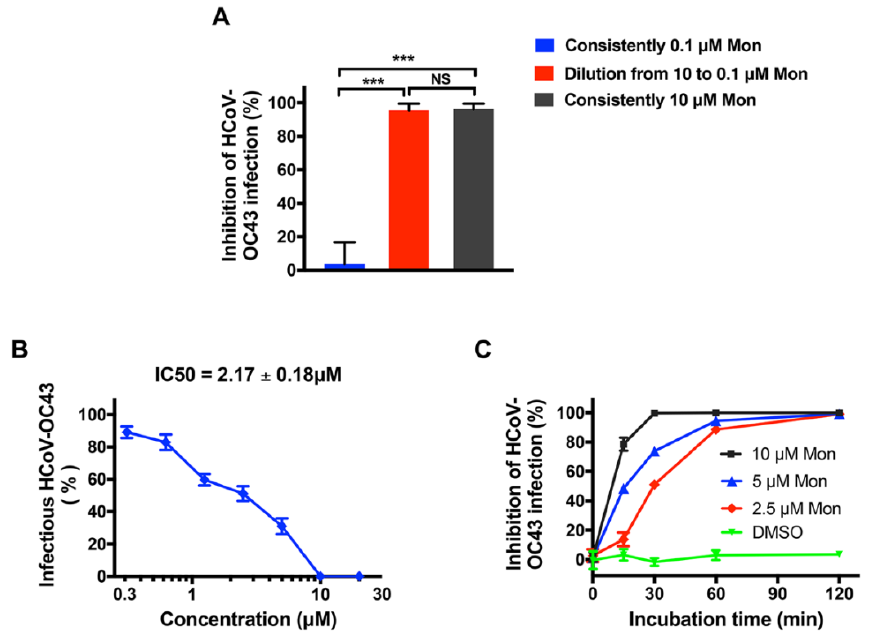
Figure 5. Montelukast (Mon) directly inactivated HCoV-OC43 particles in an irreversible and time-dependent manner. ( A ) Antiviral activity of montelukast against HCoV-OC43 was irreversible. The viruses were incubated with montelukast (10 µM) for 1 h, and then the mixture was diluted by 100-fold, resulting in decrease of the concentration of montelukast to 0.1 µM before per- forming plaque assay. ( B ) HCoV-OC43 virions were treated with serially diluted montelukast for 2 h at 33 °C. Then, viruses were precipitated and separated from montelukast by PEG-8000 and the plaque assay was performed to detect HCoV-OC43 infectivity. ( C ) Montelukast inhibited HCoV- OC43 infection in a time-dependent manner. HCoV-OC43 was treated with montelukast (2.5, 5, and 10 µM) for different times at 33 °C, and then plaque assay was performed to detect HCoV- OC43 infectivity. Data are presented as means ±SD. NS, not signi fi cant; *** p < 0.001. The irreversible inhibition of viral infectivity by montelukast dropped a hint to us that it probably could inactivate HCoV-OC43 virions directly. Therefore, the possibility of direct inactivation of montelukast on HCoV-OC43 was evaluated as previously described [31,32]. Briefly, viruses were treated with different concentrations of montelukast, then precipitated and separated from montelukast by pelleting with PEG-8000. The number of infectious HCoV-OC43 virions were immediately determined on BHK-21 cells by plaque formation assay. As shown in Figure 5B, with the increase of montelukast concentration, the number of infectious HCoV-OC43 particles gradually decreased. Thus, montelukast could indeed directly inactivate HCoV-OC43, with IC50 value of 2.17 ± 0.18 µM. To investigate how quickly montelukast could inactivate the virus, the mixture of HCoV-OC43 and montelukast was collected at the indicated times (15, 30, 60, and 120 min) and the plaque formation assay was immediately performed. HCoV-OC43 treated with 10 µM of montelukast almost completely lost infectivity within 30 min of incubation (Figure 5C). Additionally, as the incubation time increased, the number of infectious HCoV-OC43 virions treated with lower concentrations of montelukast gradually de- creased to the same extent as with 10 µM. Overall, these results suggested that